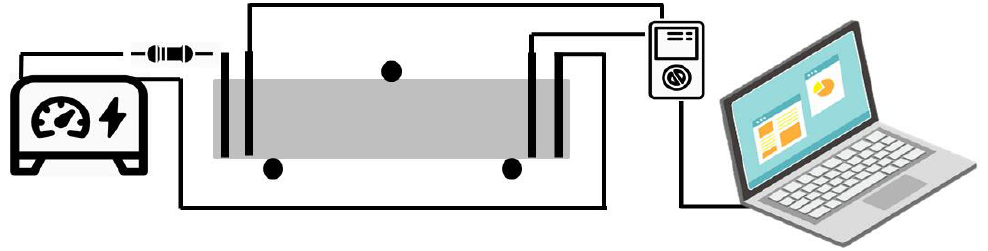
Figure 6. Scheme of the three-point-bending test under static and dynamic loading and circuit setup.